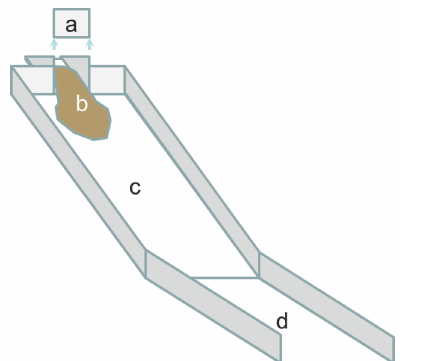
Figure 5. Iso-view sketch of the hillslope debris-flow flume. Mate- rial (b) is released from the reservoir at the top by the sudden verti- cal removal of a gate (a) and flows down a steep slope (c) followed by a gently inclined run-out plane (d).